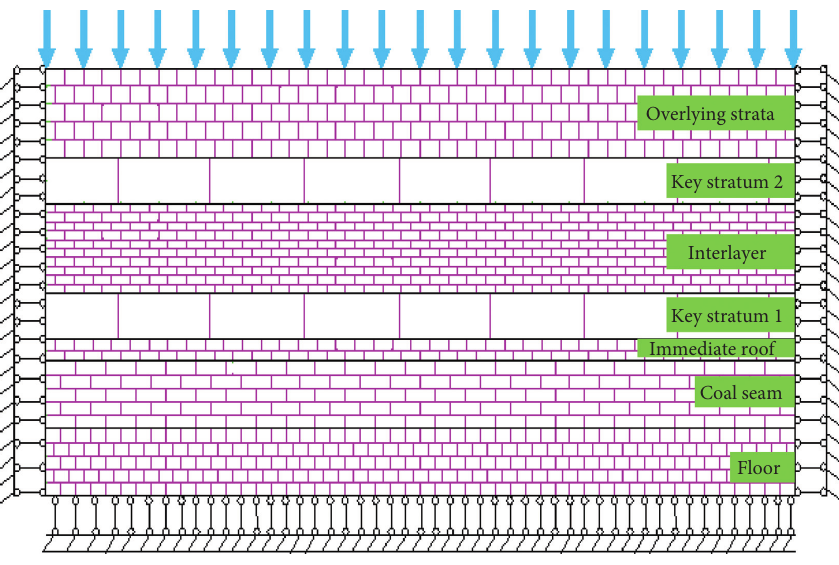
Figure 11: Numerical model.